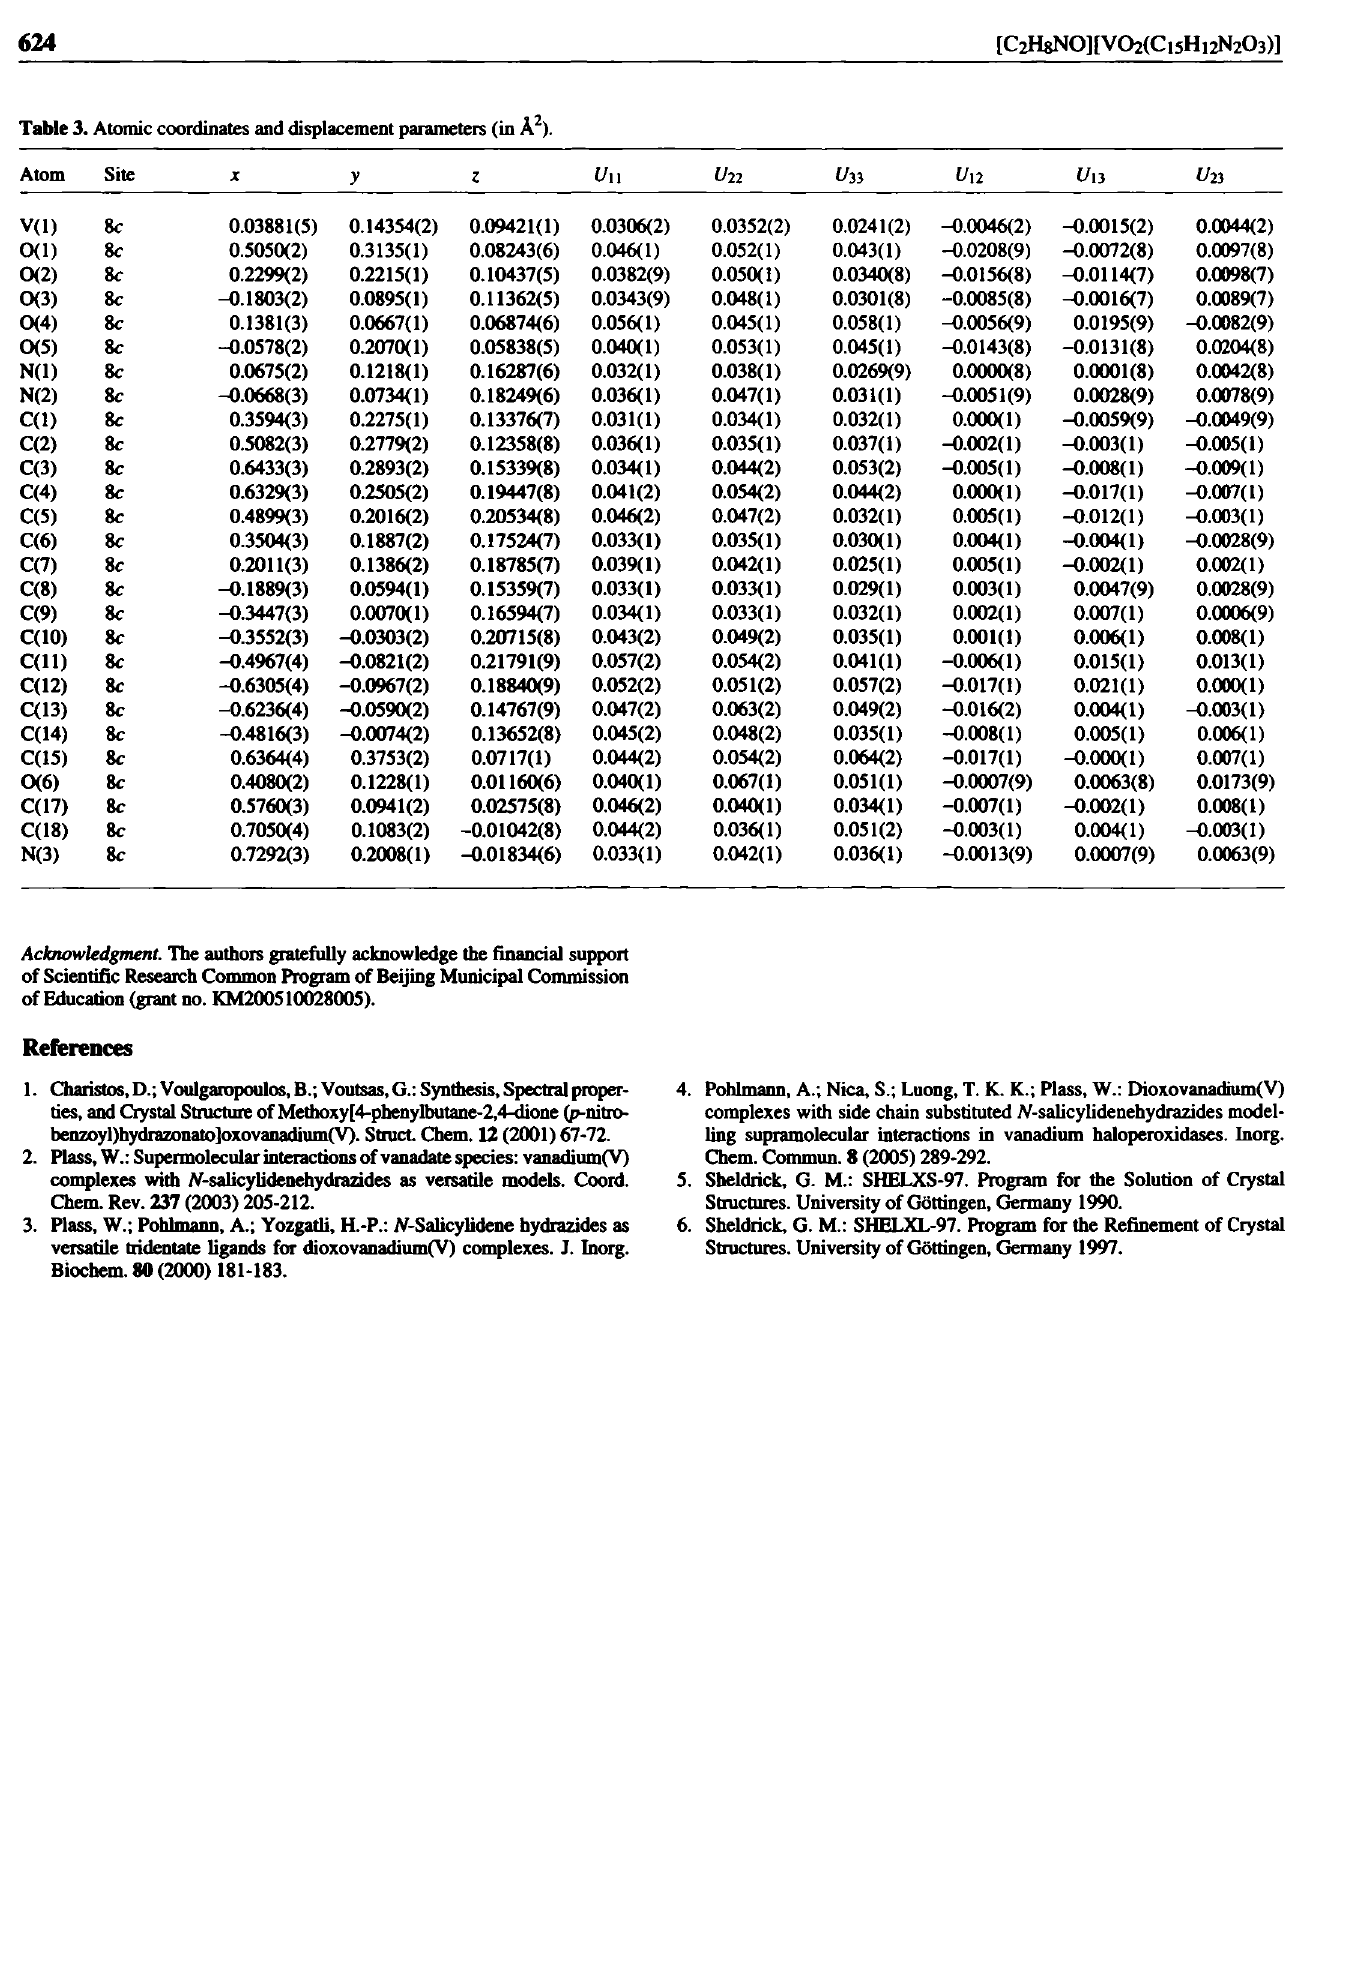
Table 3. Atomic coordinates and displacement parameters (in A 2